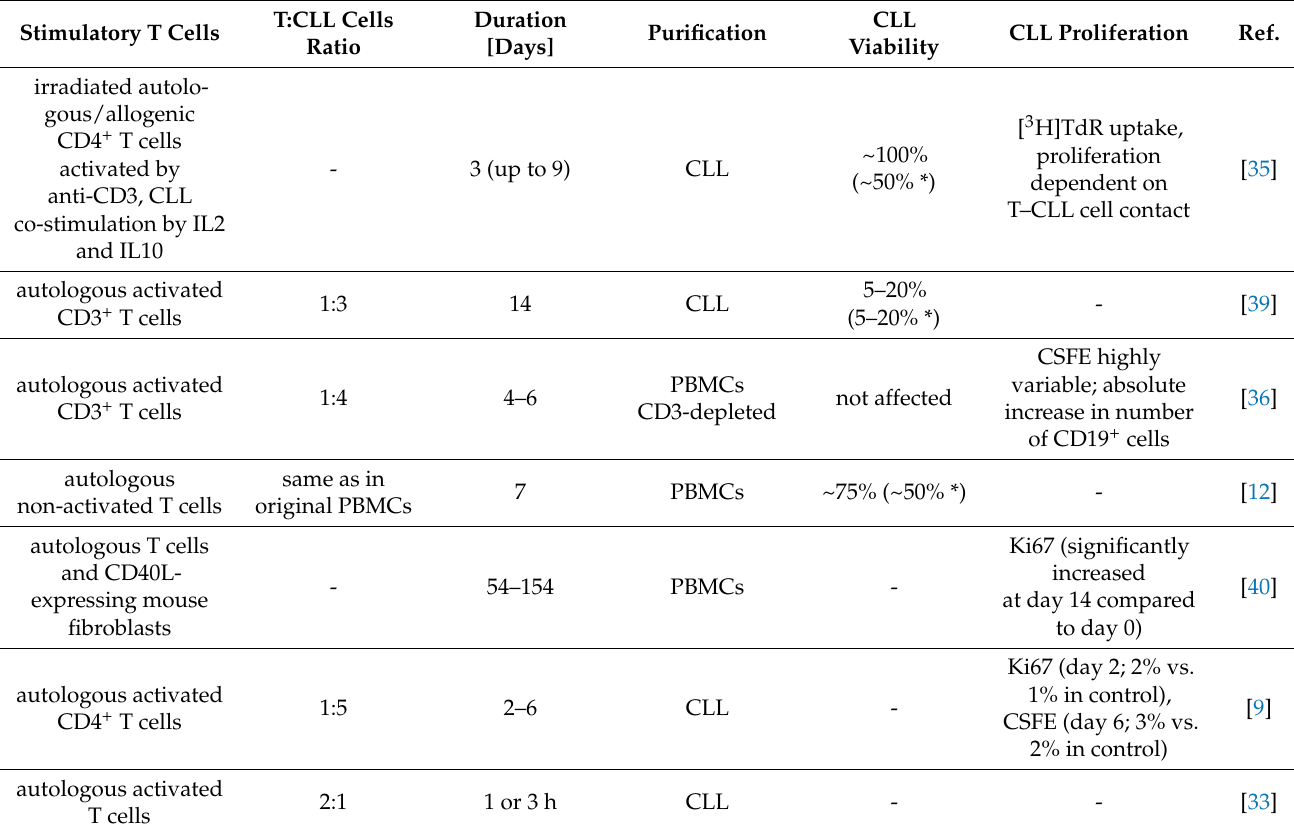
Table 1. In vitro models utilizing co-culture of CLL cells with primary T